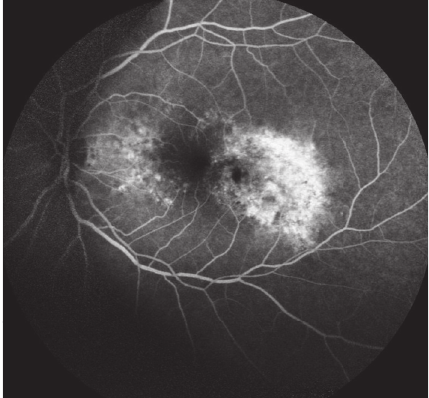
Figure 2: Fluorescein angiogram of the left eye, showing a leaking choroidal neovascular membrane.